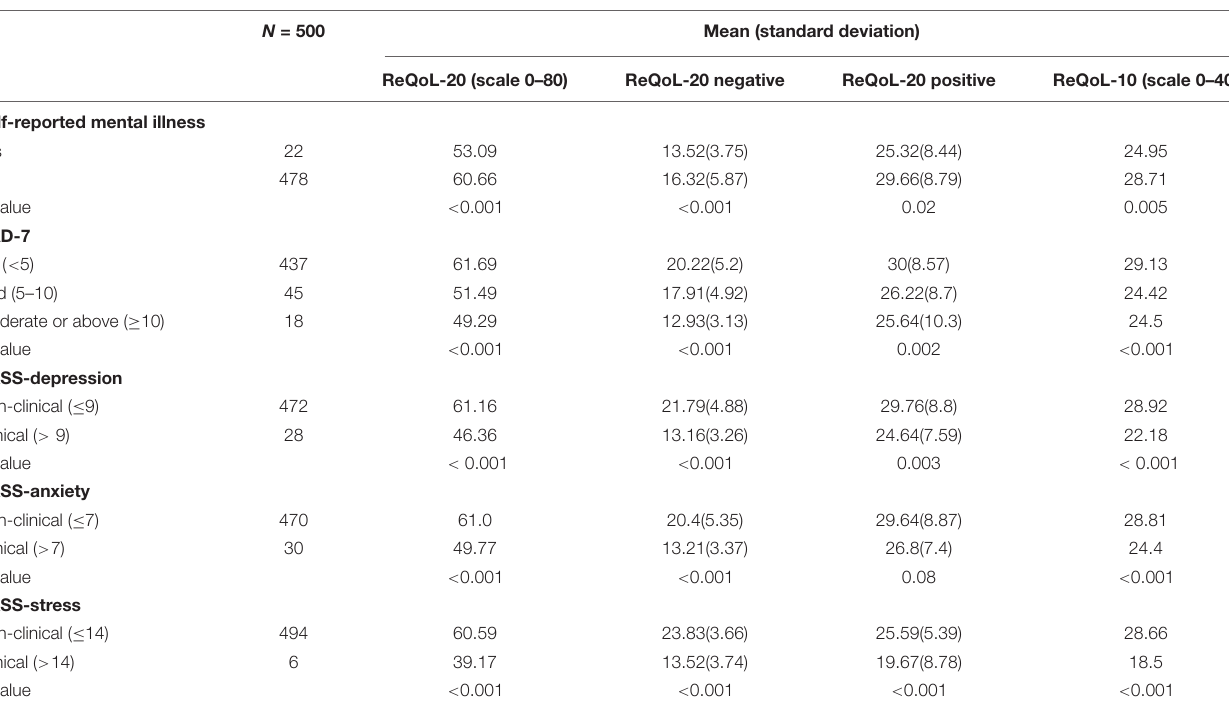
TABLE 6 | Known-group validity of the